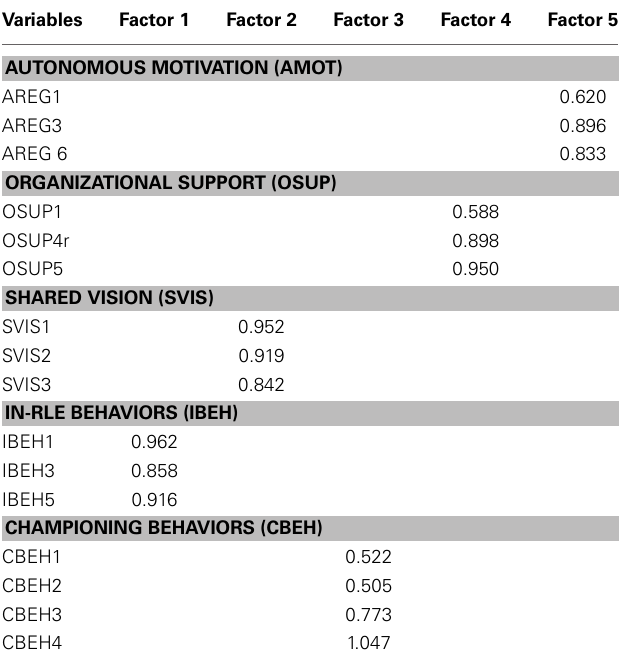
Table 3 | Simultaneous EFA of observed variables with rotated factor loadings (n-285, EFA conducted with principal axis factoring and promax rotation and kaisaer